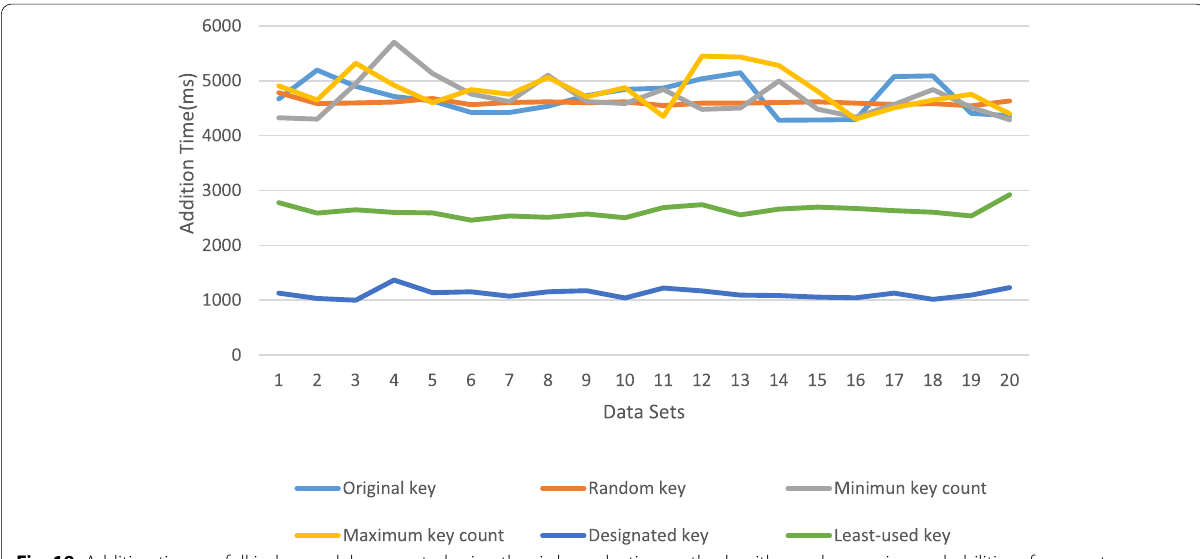
Fig. 18 Addition time on full index models generated using the six key selection methods with equal appearing probabilities of parameters